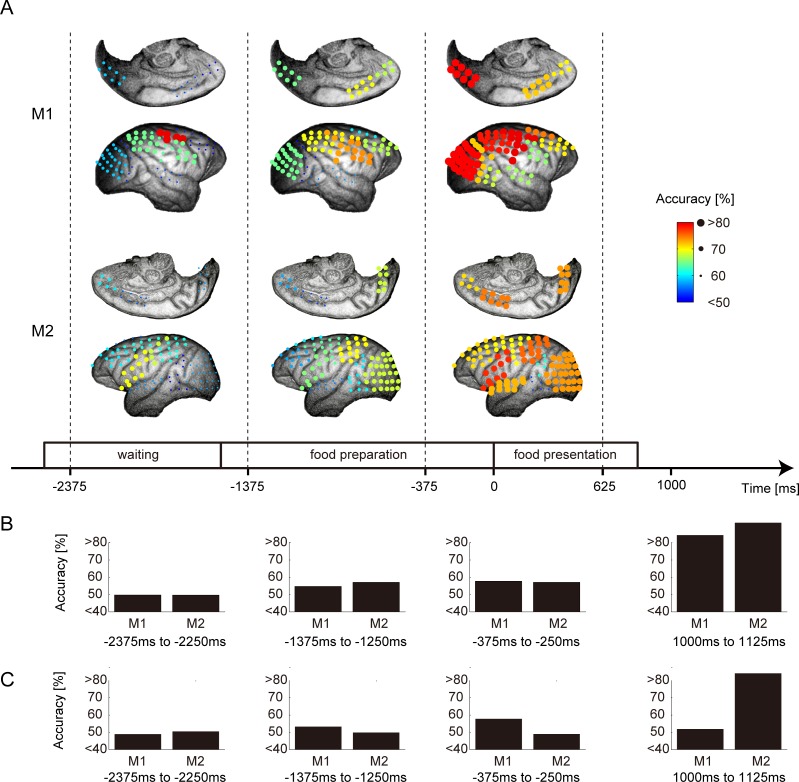
Comprehensive spatiotemporal pattern of the representation of social conditions.A: The spatial distribution of the accuracy of the spatiotemporal neural classifier in the conflict–contralateral condition for monkeys M1 and M2. The size and color of each circle are proportional to its accuracy. Three successive long time bins were selected from the waiting, food-preparation, and food-presentation periods (left, middle, and right). Dashed lines indicate the boundary of the long time bins. Numbers are shown relative to the start time of the food-presentation period under the time line indicating the start and end time of each long bin. B: The accuracy of the temporal neural classifier that discriminated whether the monkey used its right or left hand during the movement period for monkeys M1 and M2 during four time windows. C: The accuracy of the classifier that discriminated reward outcome from neural activity and outcomes of the preceding three trials during four time windows.